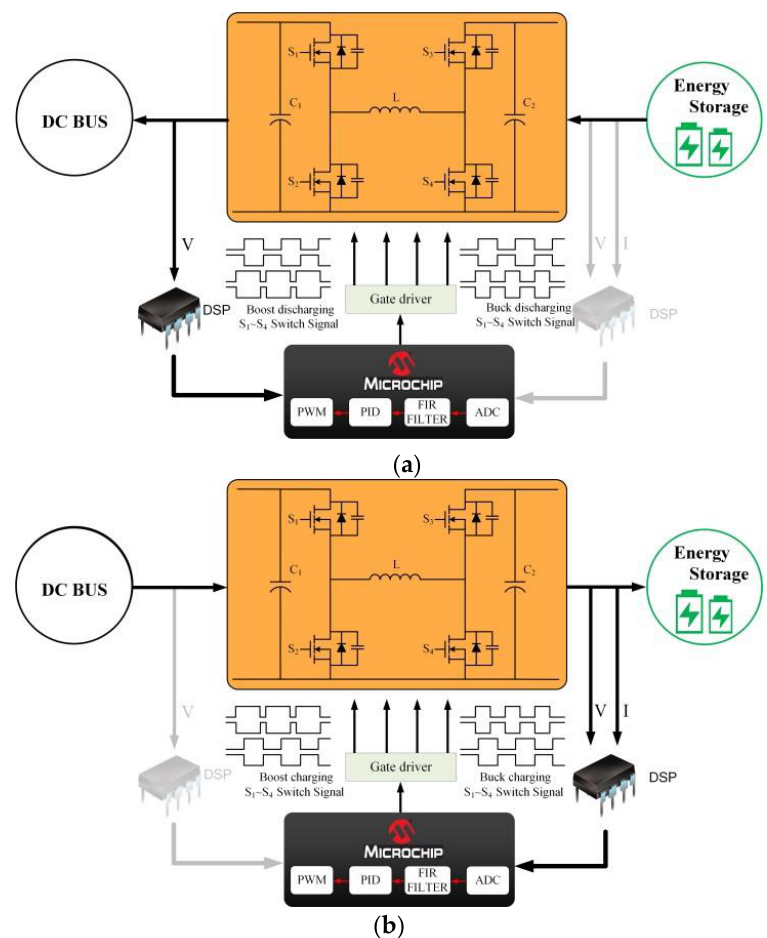
Figure 9. Block diagram of the proposed system.